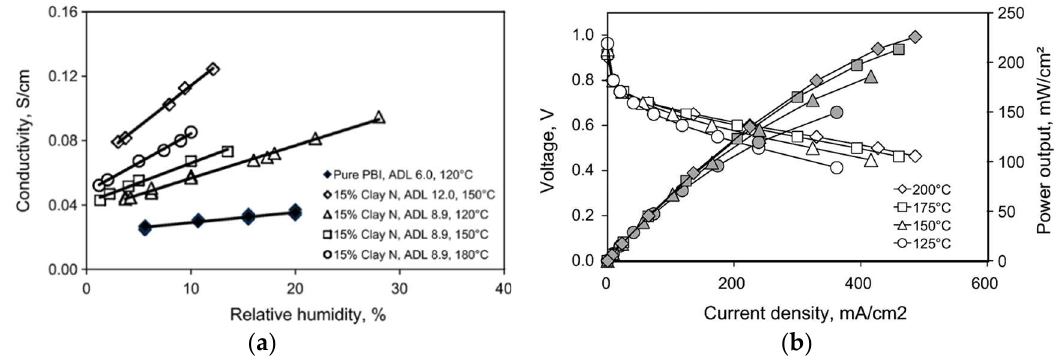
Figure 18. Conductivity of PBI membrane and PBI/clay N composites as a function of relative humidity at different temperatures ( a ); polarization curve for a fuel cell with PBI/5 wt.% clay L composite membranes (ADL = 8.2) obtained at different temperatures ( b ). Reprinted with permission from Ref. [141]. Copyright 2011 Elsevier.